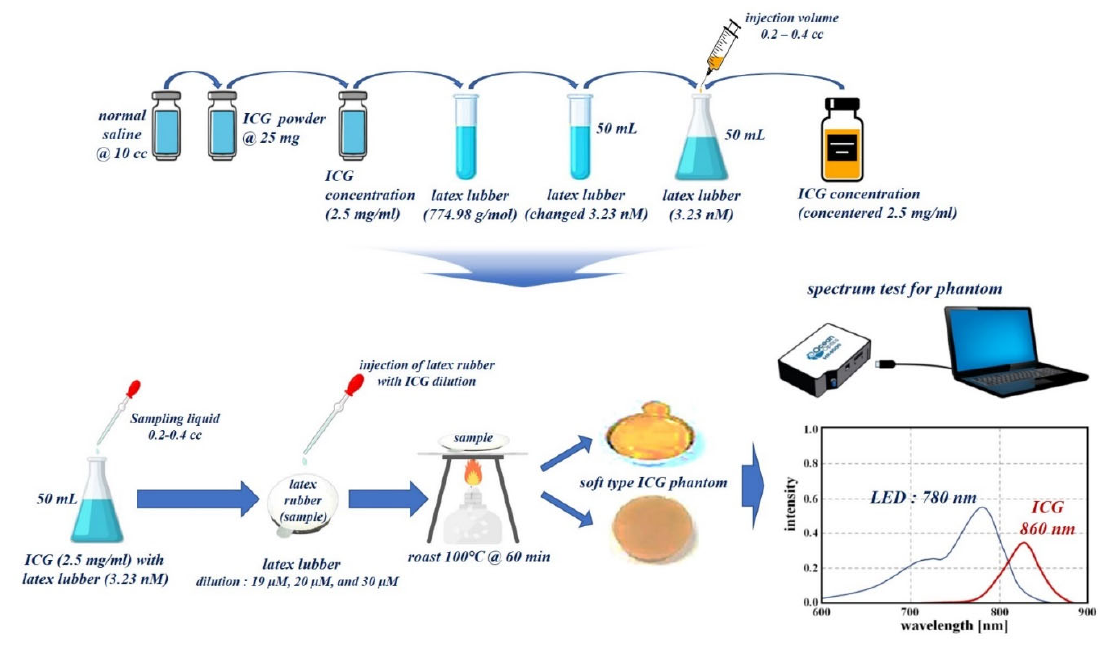
Figure 12. Proposed manufacturing of phantom using ICG and latex solution.